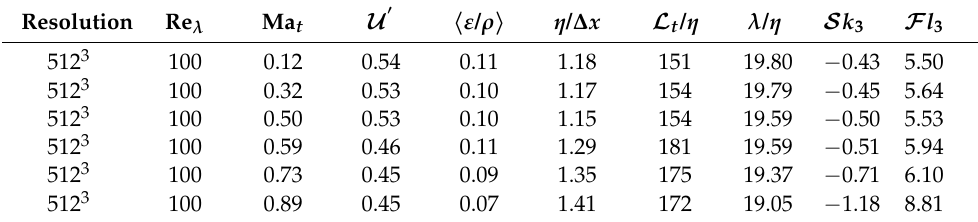
Table 1. Flow parameters used for the present DNS